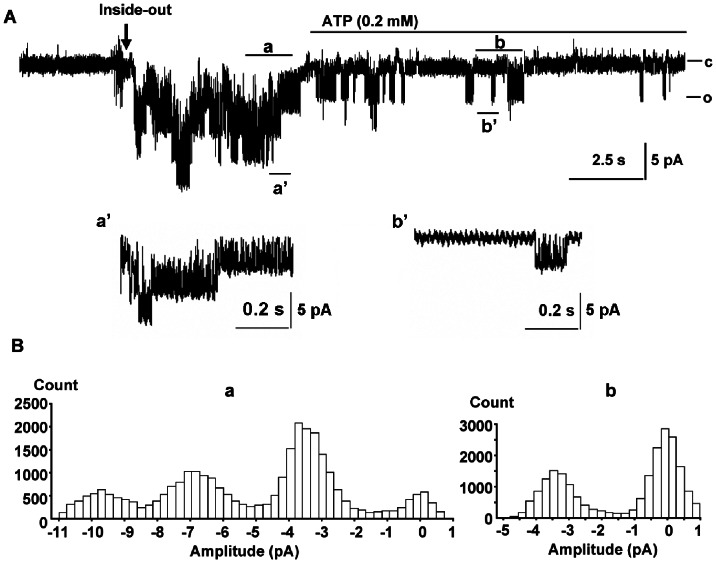
KATP currents in an inside-out patch from a rat ventricular myocyte.A: Currents were continuously recorded at −60 mV in symmetrical solutions. Channel activity increased upon excision and decreased with MgATP (0.2 mM). Inward current is downward. The lower current traces (a’ and b’) show the channel activities at a higher time resolution picked from the record at times marked with the corresponding letters in the upper traces. B: All-points histograms (a and b) of the data segments tagged with a and b in panel A, showing the same unitary current before and during MgATP.